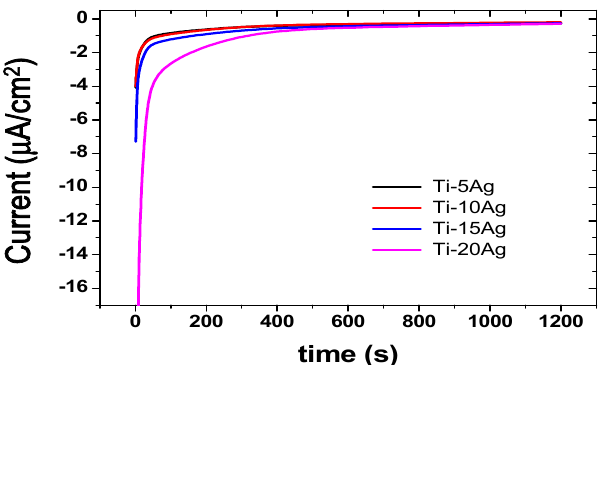
Figure 9. Mean values of galvanic currents vs. time of the couplings of cp-Ti/Ti– x Ag